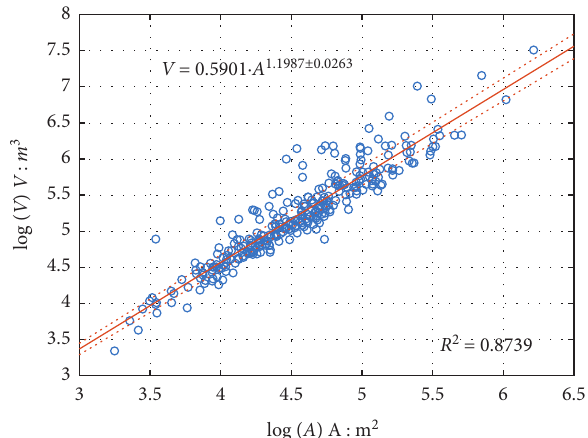
Figure 6: Relation between the landslide volume and landslide area in logarithm.